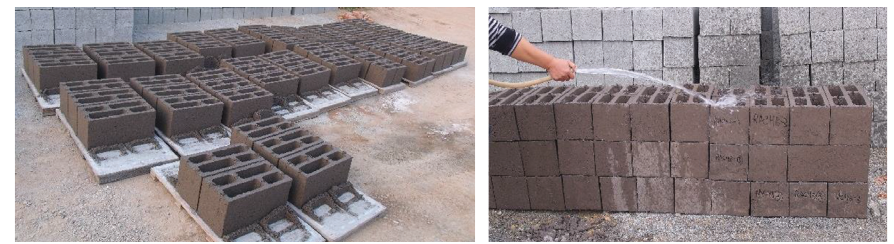
Figure 3: Recycled concrete hollow block in natural outdoor water curing